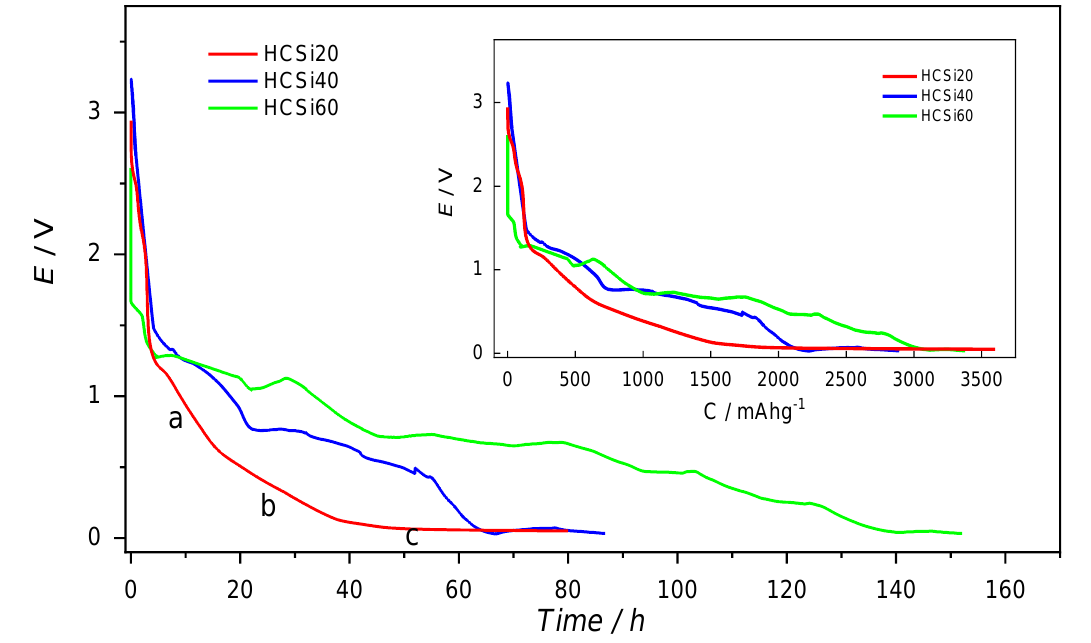
Figure 4. Chronopotentiometic curves for electrodes HCSi20, HCSi40 and HCSi60 at constant current of − 100 µ A. Galvanostatic discharge with specific capacities for electrodes HCSi20, HCSi40 and HCSi60 (inset).